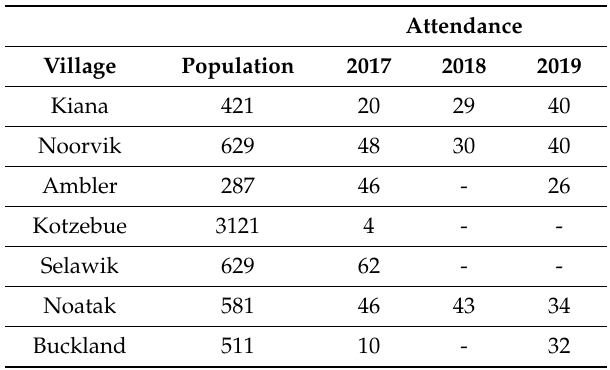
Table 1. Table of results from the Caribou Hunter Success Working Group community meetings showing the population of the village and attendance for 2017, 2018, and